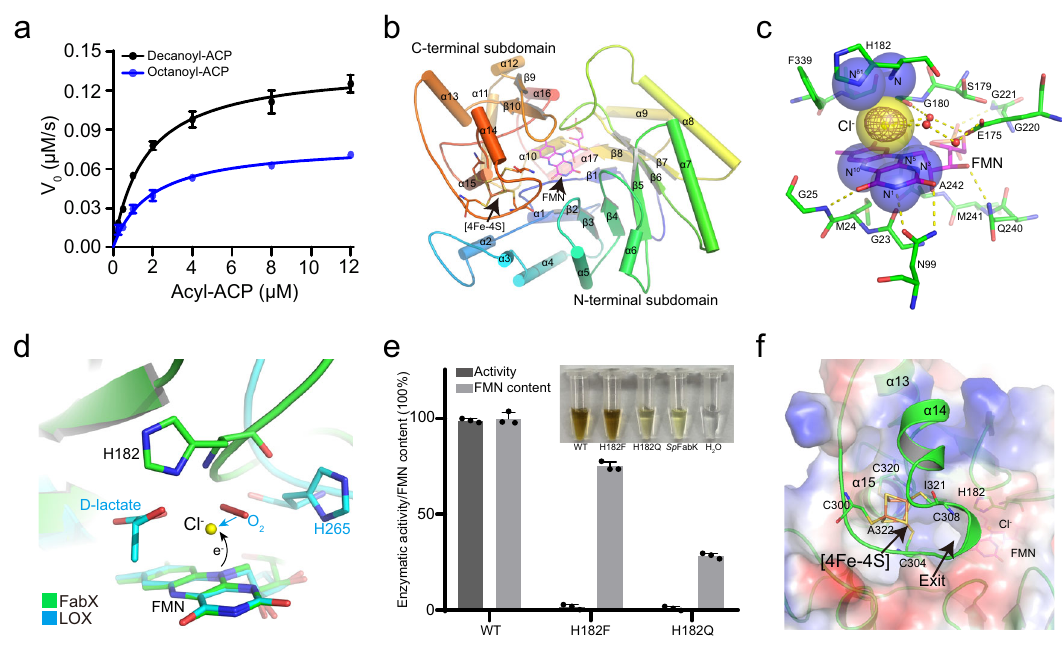
Fig. 2 Structural characterization of FabX. a Kinetic characterization of FabX catalysis with decanoyl-ACP (black) and octanoyl-ACP (blue). The curves were fi tted to the Michaelis – Menten equation. N = 3 biologically independent experiments. Data is presented as mean ± SD. b The overall crystal structure of FabXs colored blue to red from N- to C-terminus. The FMN cofactor and [4Fe – 4S] cluster are shown as sticks. The two subdomains, secondary structural elements, FMN cofactor, and [4Fe – 4S] cluster are labeled. c The FMN-binding motif of FabX. The residues and water molecules involved in FMN binding are shown in green sticks and red spheres, respectively. Yellow dashes indicate hydrogen bonds between FMN and surrounding amino acid residues. The nitrogen atoms (N and N δ 1 ) of H182 and FMN (N 1 , N 3 , N 5 and N 10 ) that contribute to oxyanion hole formation are presented as labeled transparent blue spheres. The chloride ion found locked in the oxyanion hole is shown as a transparent yellow sphere, and its fofc electron map ( σ = 3) is shown in brown mesh. d Structural superposition of FMN-binding motif of FabX (green) with that of lactate oxidase (LOX, cyan, pdb code: 2NLI) 23 . The FMN cofactor, key histidine residue (His265), and D -lactate of the LOX structure are shown as cyan sticks, while the O 2 molecule observed in the LOX structure is shown in red sticks and labeled. FabX His182, FMN and the chloride ion are shown in green sticks and yellow sphere, respectively. The cyan arrow indicates that the replacement of the chloride ion with an oxygen molecule during catalysis. e Dehydrogenation activities (black) and FMN contents (gray) of FabX, FabX H182F and FabX H182Q variants, determined by the FabX – FabI coupled assay and LC – MS/MS, respectively. The protein color of the variants was shown and labeled. N = 3 biologically independent experiments. Data is presented as mean ± SD. f The electrostatic surface of FabX with the [4Fe – 4S] cluster binding residues. Four key cysteine residues (C300, C304, C308, and C320) and the residues involved in interactions with the cluster are shown as sticks and labeled. The exit of the active site tunnel of [4Fe – 4S] cluster is indicated by black arrows. Source data are provided as a Source Data fi